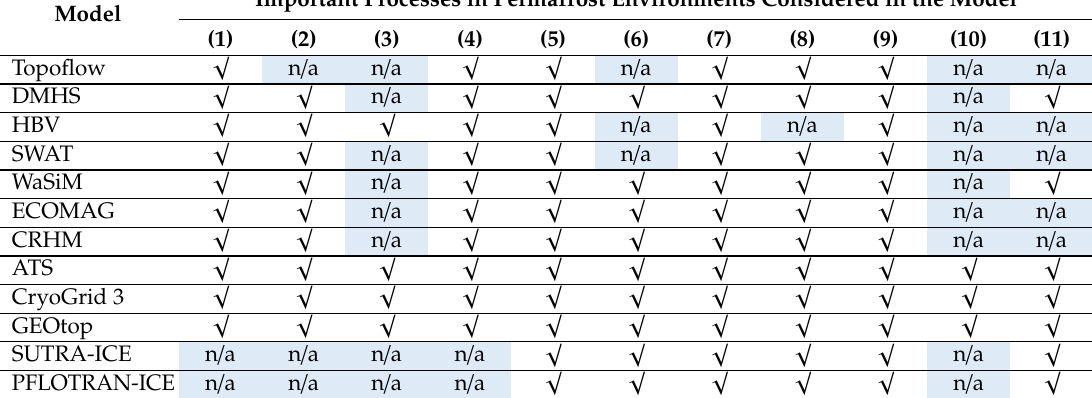
Table 1. Model comparison regarding the model’s capacities to simulate the important processes in permafrost